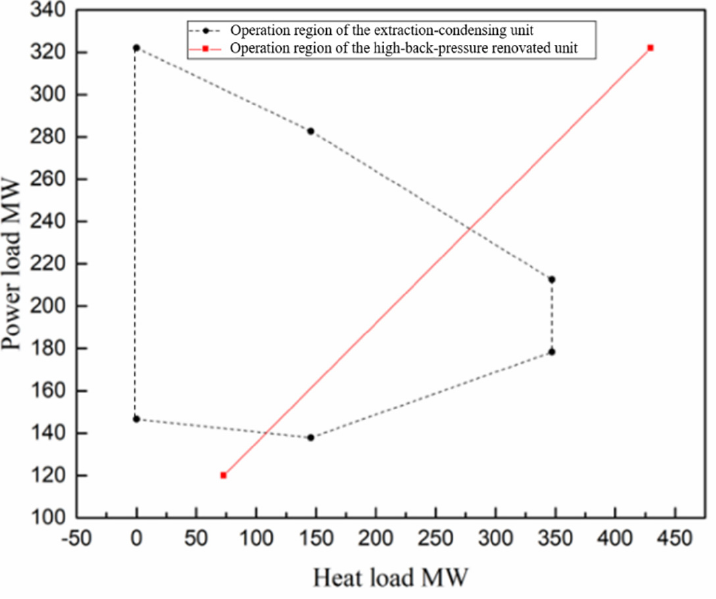
Figure 7. Operation region of #2 unit.